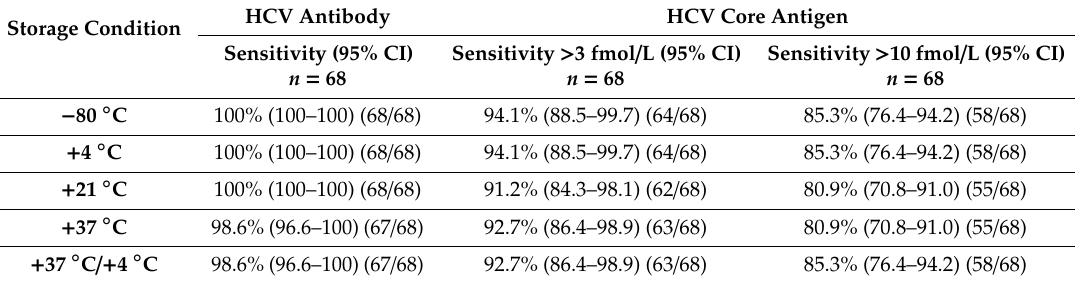
Table 1. Sensitivity and specificity of hepatitis C Virus (HCV) antibody and antigen on dried blood spots (DBS) by storage